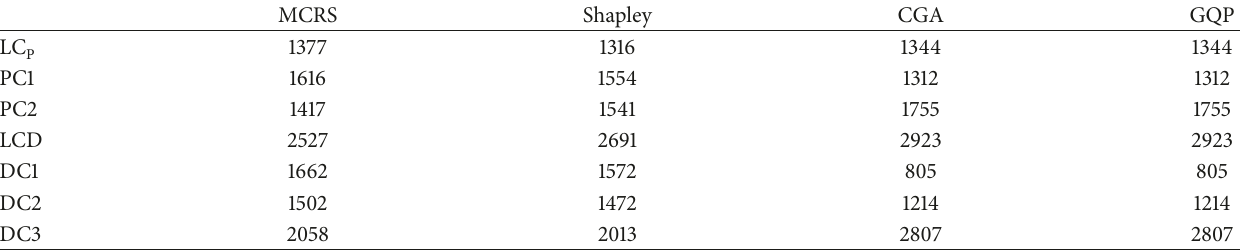
Table 9: Profit allocations according to MCRS, Shapley, CGA, and GQP.